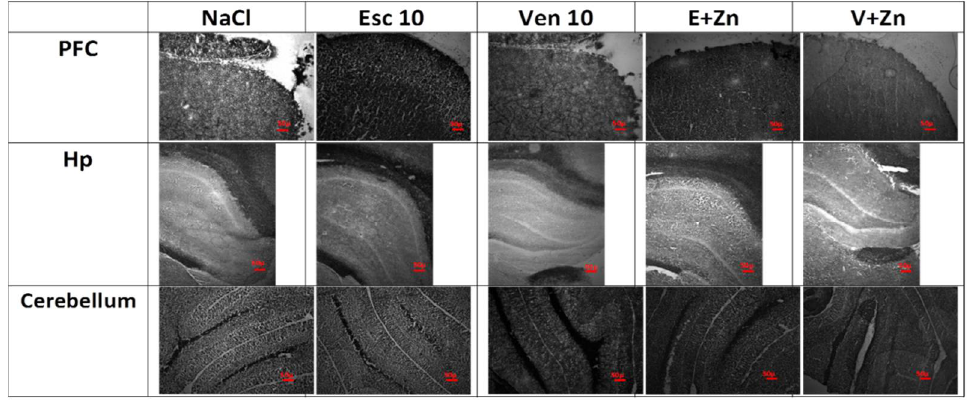
Figure 4. The representative images of the effects of antidepressants (Esc, Ven) and Zn supplementa- tion on synaptic zinc levels in the prefrontal cortex (PFC), hippocampus (Hp), and cerebellum of rats subjected to the OB + ZnD model (Timm staining). Scale bar = 50 µ